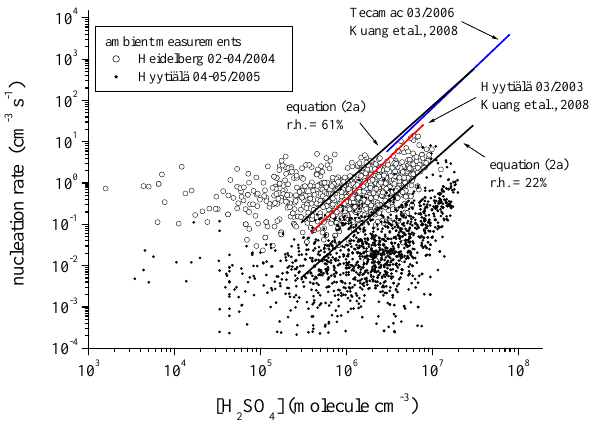
Fig. 9. Detected mean particle diameters from DMPS and PHA- UCPC measurements as a function of H 2 SO 4 concentration; RH 22% or 61%; total gas flow 11lmin − 1